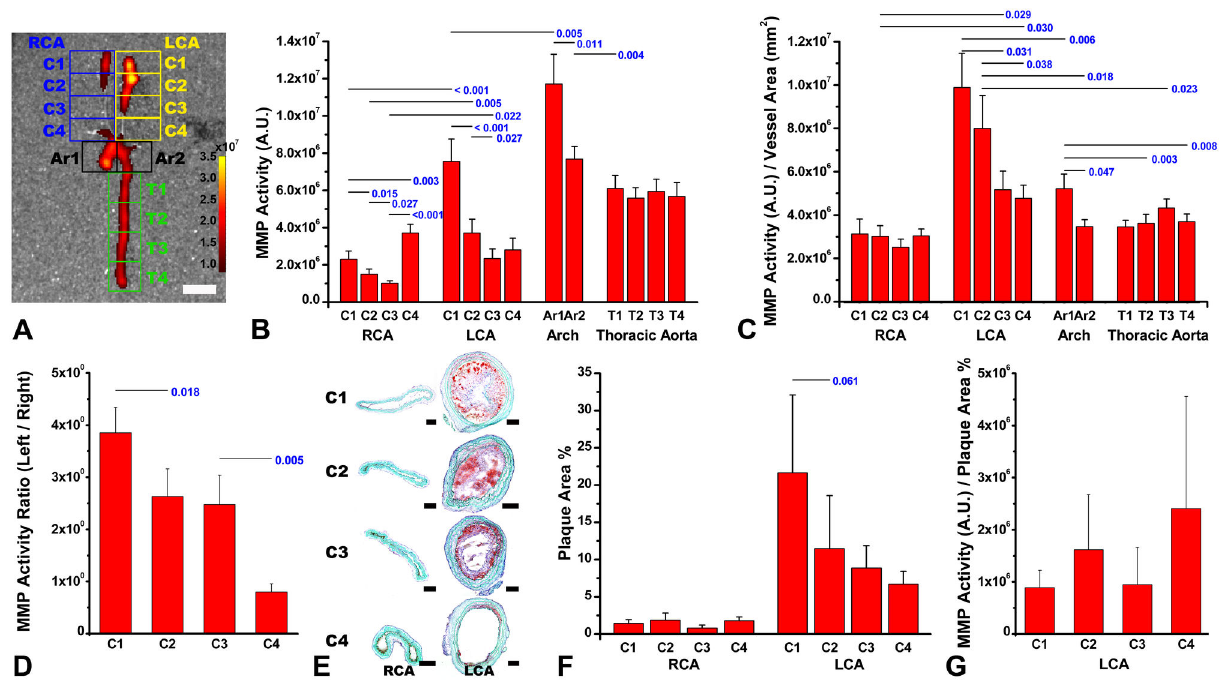
Figure 1. Strong matrix metalloproteinase (MMP)-2/9-related near-infrared fluorescent (NIRF) signal in and around the ligated area of the left common carotid artery (LCA) of ApoE -/- mice fed on a western diet. Two weeks after partial ligation of the LCA, there is a gradient of MMP-related fluorescence (mean intensity / tissue area in a rectangular region of interest) that is maximal close to the ligation site / bifurcation point (A, LCA C1 or C2), and progressively decreased as one move inferiorly closer to the arch both on the right and on the left, but the maximum is much higher on the ligated left side (A and B). The arch itself shows the highest activities measured, particularly proximally, close to the aortic root (B, Ar1 vs. Ar2). However, the MMP activity per vessel area in each square region of interest is highest in the LCA ligation site (C, LCA C1 and C2). There is a decreasing gradient in the left-to-right ratios of the NIRF signal intensities (D) and oil red O staining-positive atherosclerotic lesion size (E and F) in the four carotid segments. MMP activity / plaque size ratios in the left CCA do not show significant regional differences (G). Pseudo- color overlaid NIRF signal in the aorta and arteries with intensity expressed as arbitrary unit (A). RCA denotes the right common carotid artery. Statistically significant or marginally significant p values from paired-t tests are provided. White scale-bar, 1 mm; black scale-bars, 100